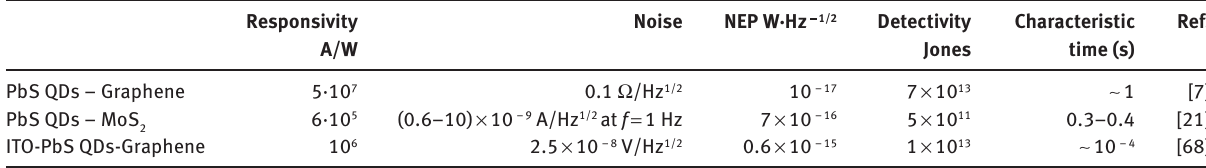
Table 3: Noise characteristics of hybrid